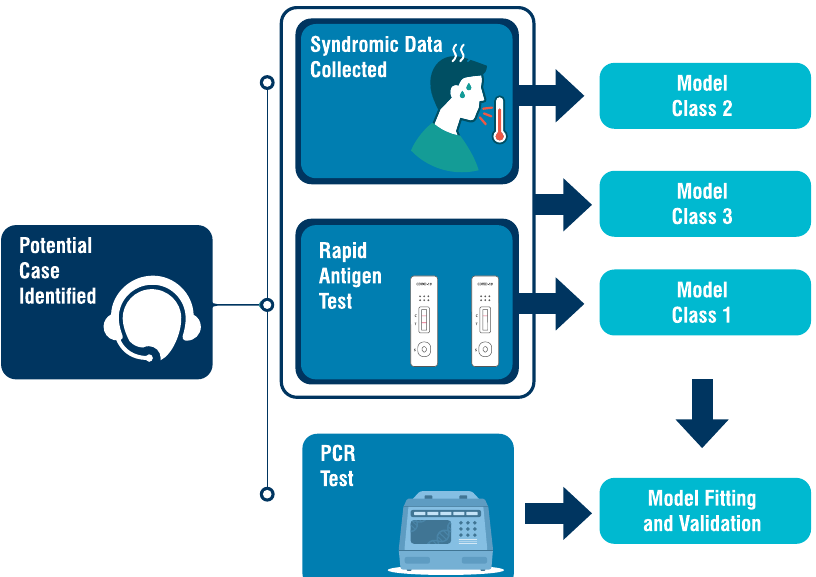
Fig. 4 Schematic description of identi fi cation of likely COVID-19 cases by community support teams (CSTs) and model de fi nitions. CSTs collect syndromic data (age, gender and presence/absence of 14 predetermined symptoms), and two sets of naso-pharyngeal swabs (for rapid antigen testing and PCR). We used three model classes: rapid antigen test only in 1, syndromic data only in 2, and both rapid antigen test and syndromic data in 3. The PCR result is used to train and test each model using temporal cross-validation.